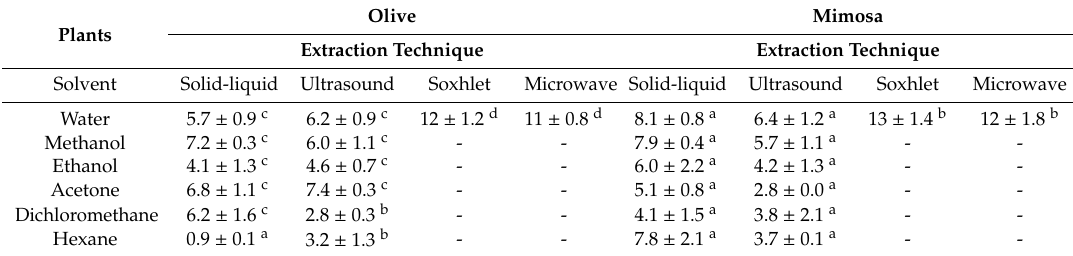
Table 1. Extraction e ffi ciency (%) per extraction technique and solvent used with both olive and mimosa